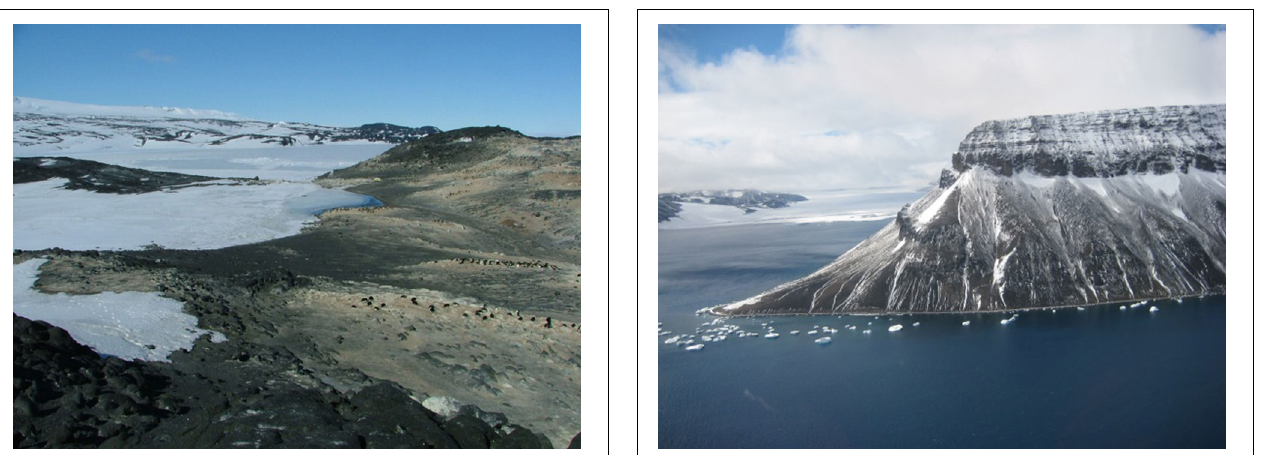
FIGURE 5 | Ornithogenic soils of an Adélie Penguin colony.